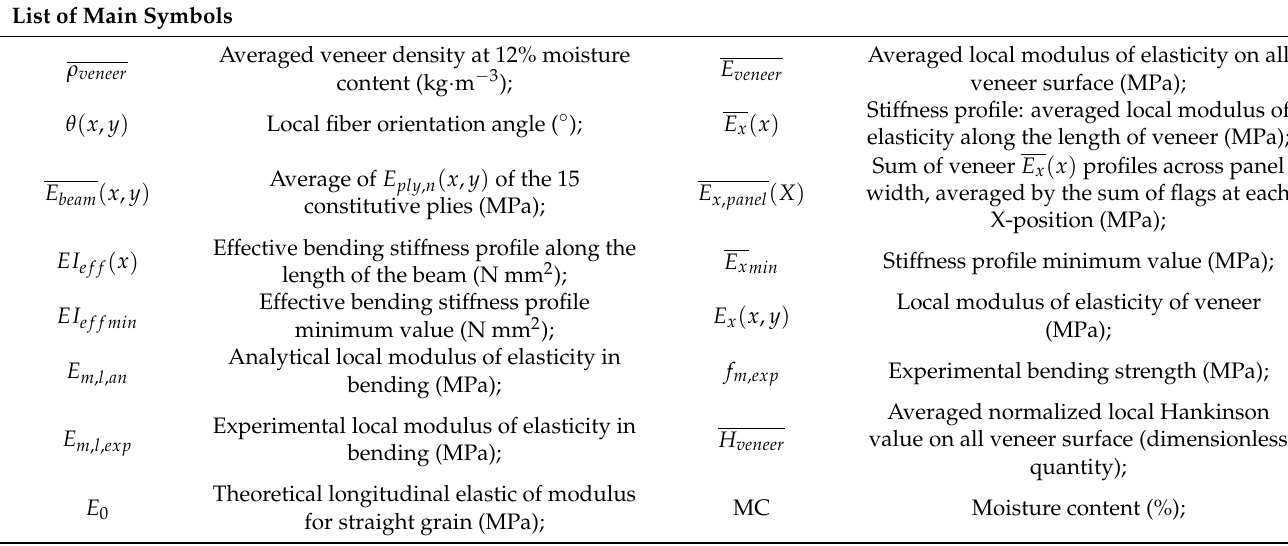
Table 1 contains the nomenclature listing the main symbols used. Table 1.